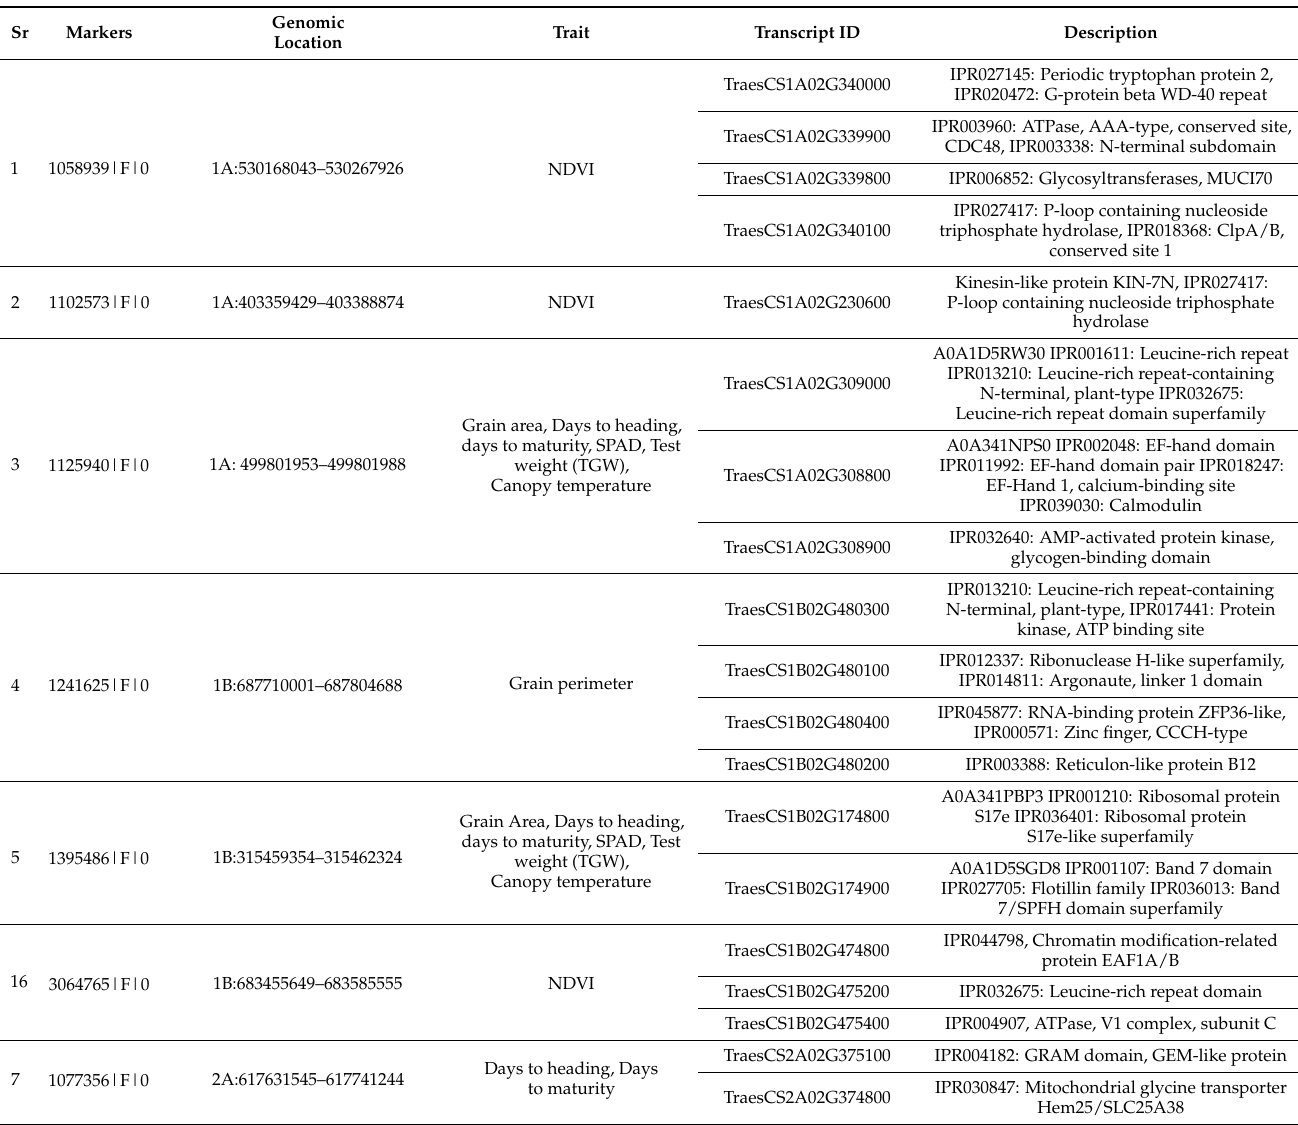
Table 3. Significant SNP and annotated proteins and transcripts on the high confidence genes